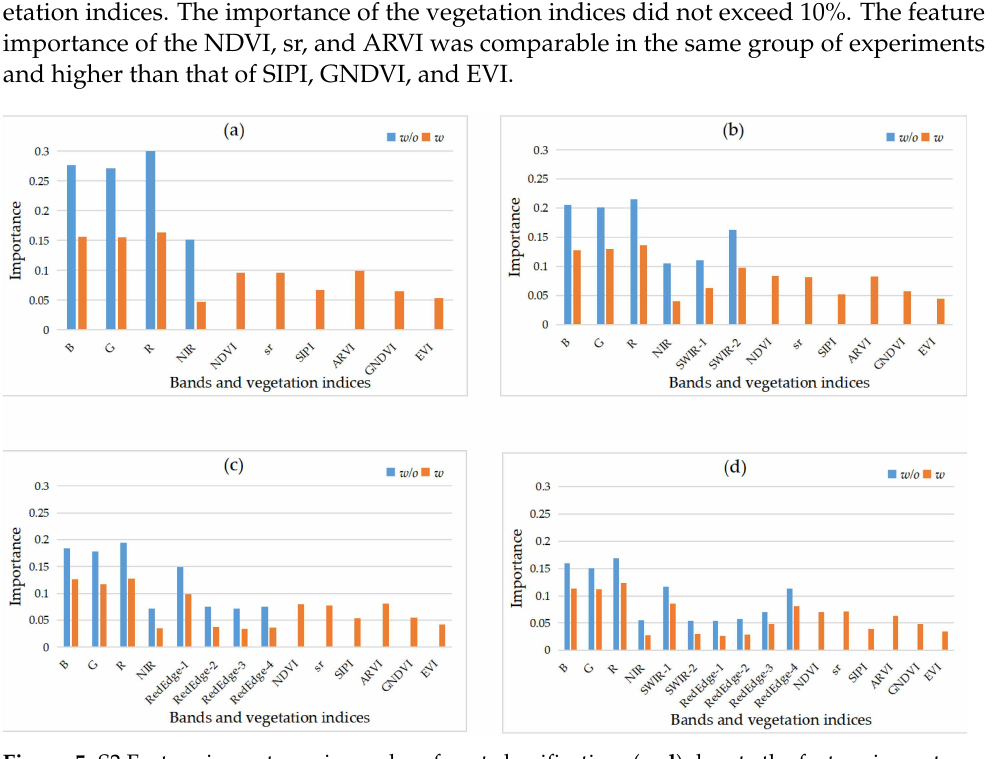
Figure 5. S2 Feature importance in random forest classification. ( a – d ) denote the feature importance of exp1, exp2, exp3, and exp4,